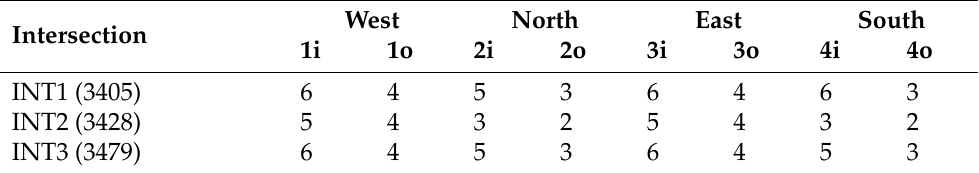
Table 2. Number of lanes for each edge of intersection